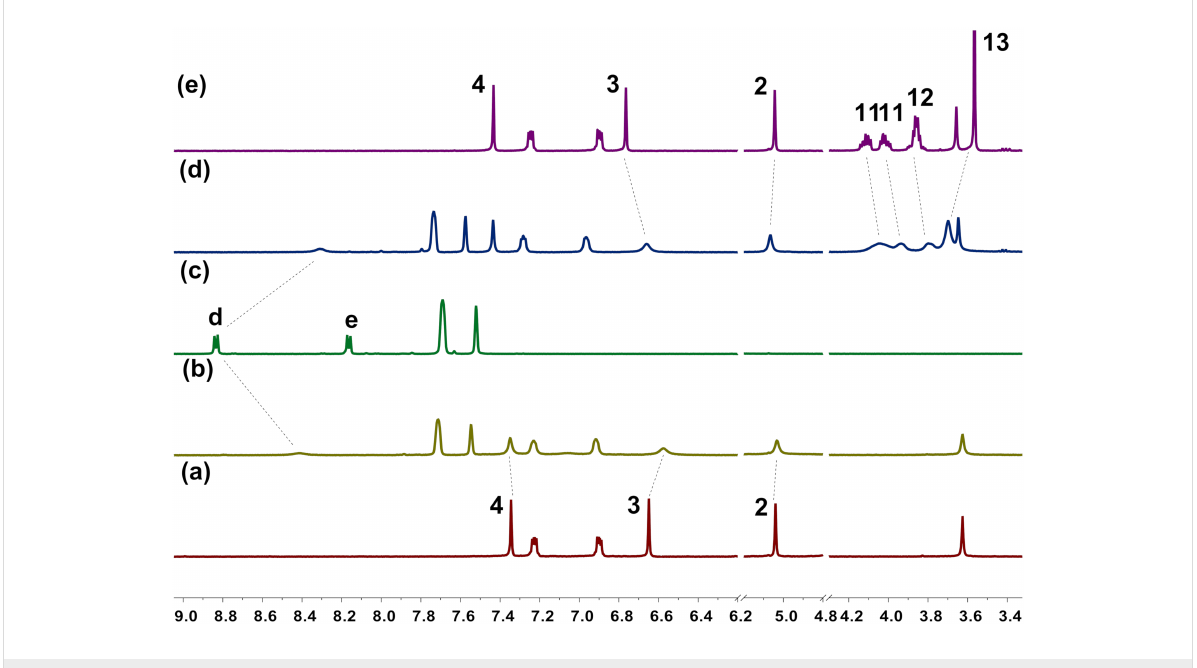
Figure 3: Partial 1 H NMR spectra (400 MHz, CD 2 Cl 2 , 298 K) of (a) free H1 , (b) H1 with 1.0 equiv G4 , (c) free G4 , (d) H4 with 1.0 equiv G4 , (e) free H4 . [ H1 ] 0 = [ H4 ] 0 = [ G4 ] 0 = 2.0